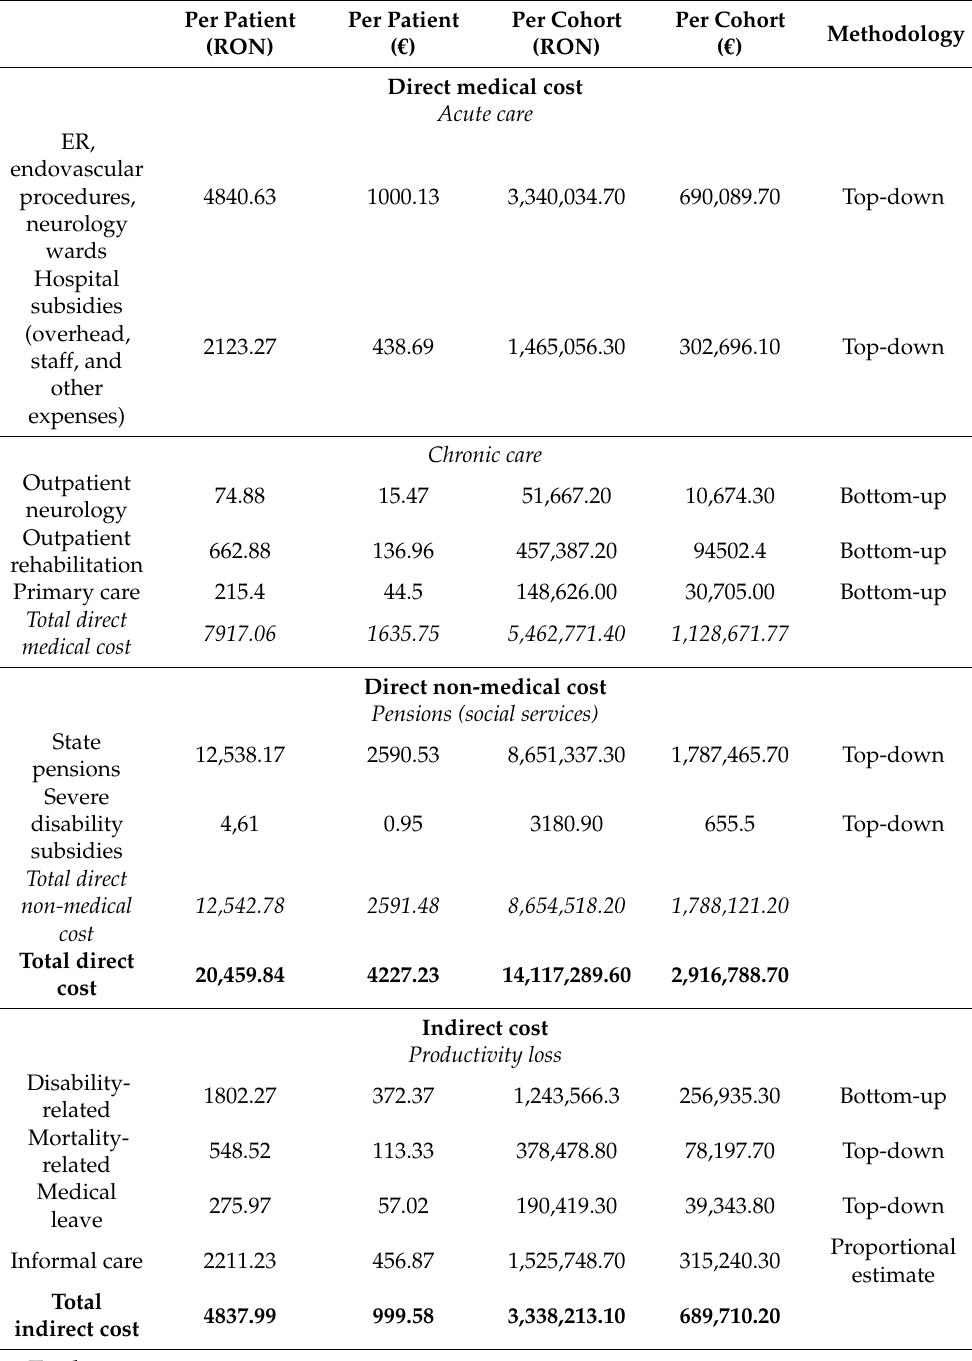
Table 3. Direct medical, direct non-medical, and indirect costs mean cost in the first year after AIS